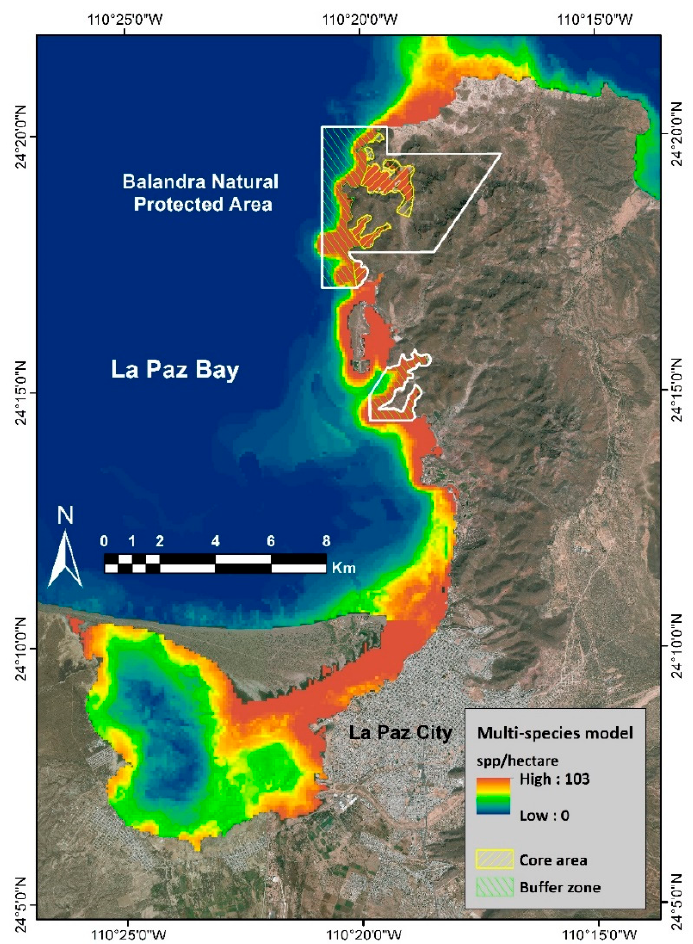
Figure 3. Multi-species distribution model. Color scale shows abiotically suitable sites for fish (species per hectare). The white polygon shows Balandra Protected Natural Area.